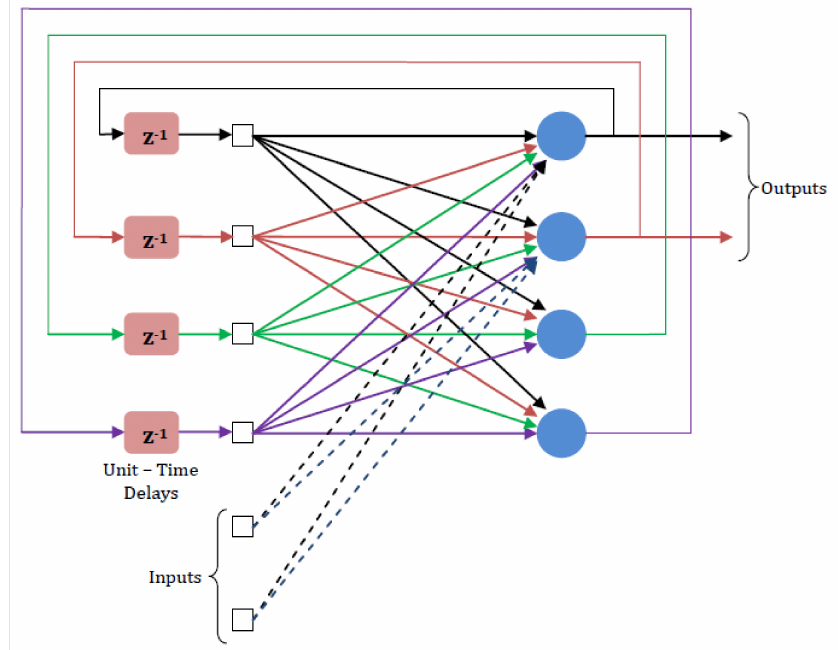
Figure 7. Recurrent network structure with hidden